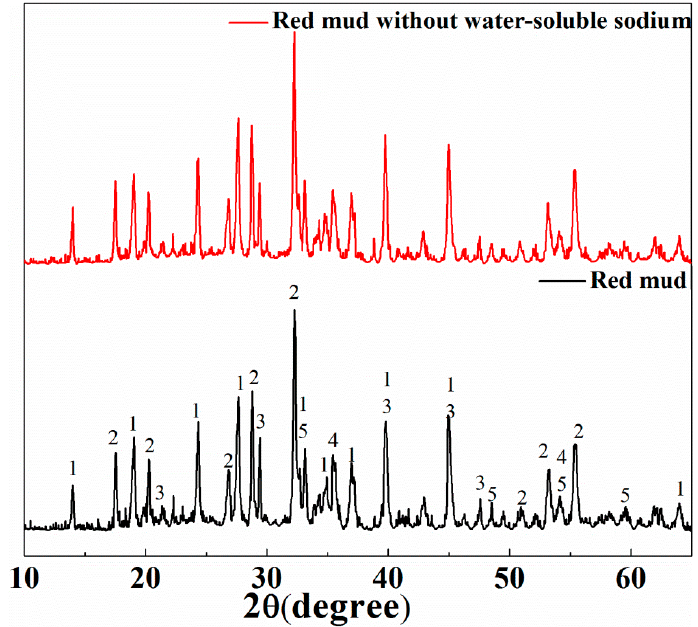
Figure 1. X-ray diffraction analysis of Bayer red mud (1—Na 8 Si 6 Al 6 O 24 (H 0.88 (CO 3 ) 1.44 )(H 2 O) 2 ; 2—Ca 2.93 Al 1.97 Si 0.64 O 2.56 (OH) 9.44 ; 3—CaCO 3 ; 4—Fe 2 O 3 ; 5—CaTiO 3 ).